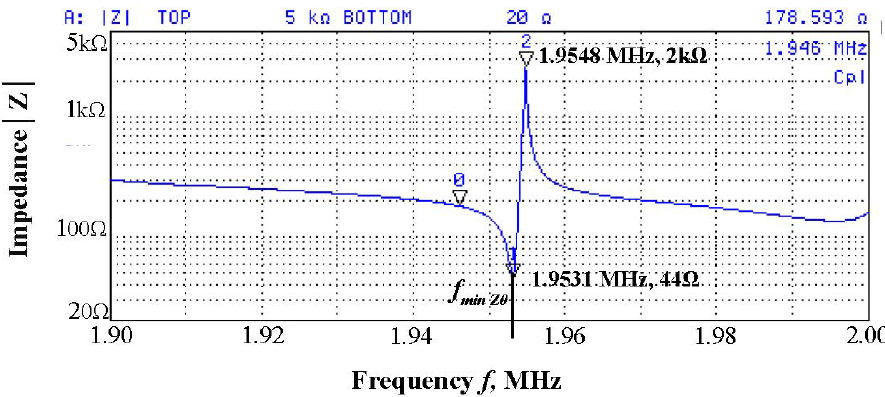
Figure 4. Figure 4. Typical impedance curve of 2 MHz 4-Fourier horn